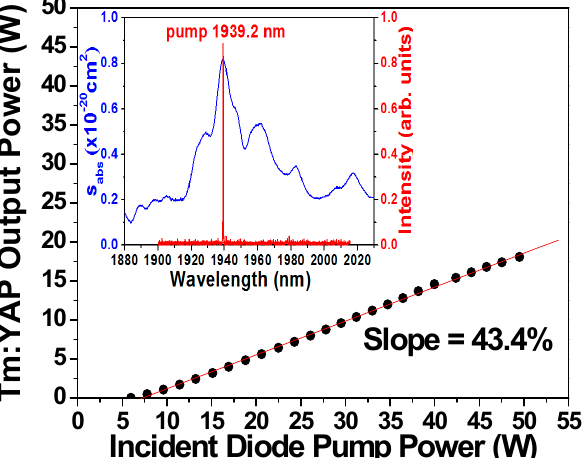
Figure 2. The performance of the Tm:YAP laser. Inset: The absorption spectrum of the Ho:SSO and the pump spectrum (the blue line is the absorption line around 1949 nm, and the red line is the emission spectrum of the Tm:YAP laser).